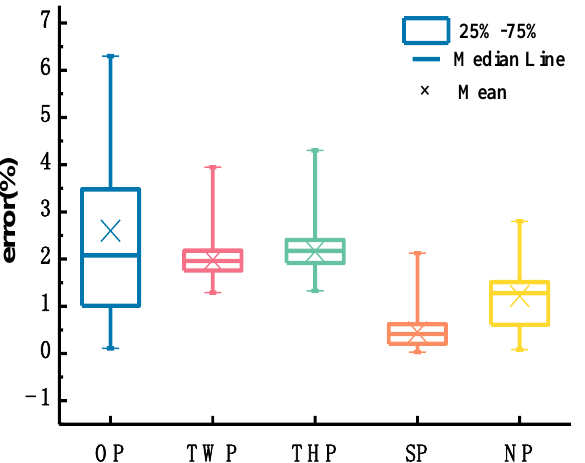
Figure 6. Comparison of velocity-estimation errors obtained from various depth-averaged velocity characterization methods (the one-point method at 0.5 H , two-point method at 0.2 H and 0.8 H , three-point method 1, six-point method, and the new method proposed by Shan et al. are indicated along the abscissa).